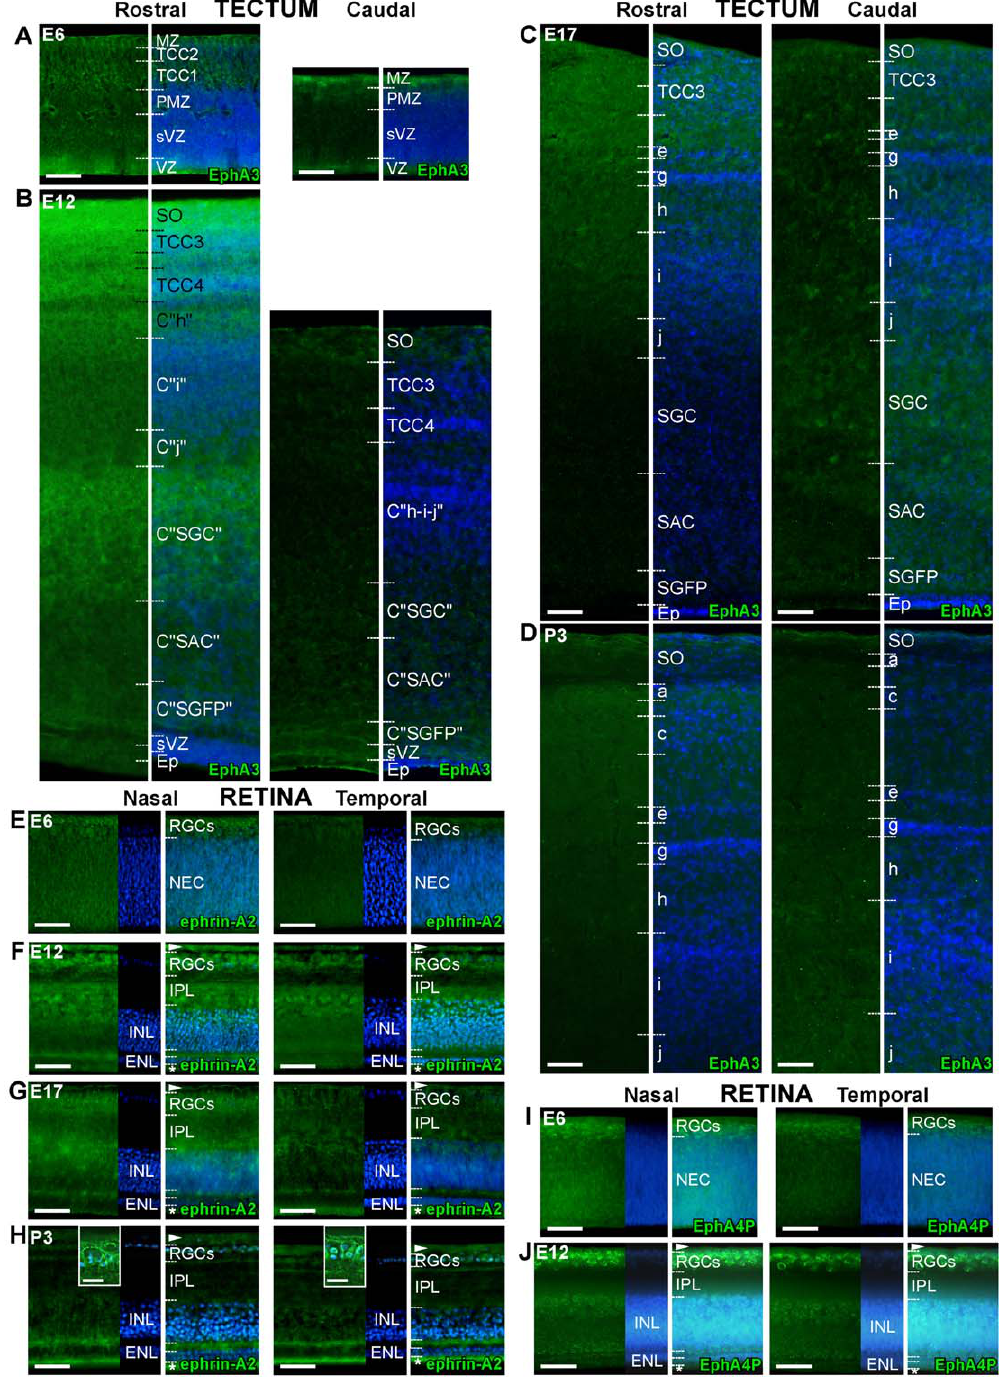
Figure 1. Developmental patterns of expression of tectal EphA3 and retinal ephrin-As and Tyr-602 phosphorylated-EphA4. (A–D) Immunofluorescence of EphA3 was performed in sections which extend along the rostro-caudal axis of tecta obtained from chicken embryos and early postnatal chicks. Photographs of rostral (left), and caudal (right) tectum obtained from the same section are successively shown at 6 (A), 12 (B), 17 days of development (C) (E6, E12, E17) and 3 postnatal days (P3) (D). Immunofluorescence (left) and merge image of immunofluorescence and nuclear labeling with Hoechst (right) of each area are shown. The lamination process is more advanced in rostral (left) than in caudal (right) tectum, so different developmental stages can be appreciated in different areas analyzed in the same age [3]. As lamination progresses, EphA3 is expressed along all the radial tectum in both areas, but the expression of superficial layers is higher in rostral than in caudal tectum. This pattern of expression is appreciated at E6 (A) and presents the highest level around E12 (B), decreasing postnatally (D). Ventricular zone (VZ), subventricular zone (SVZ), premigratory zone (PMZ), the transitory cell compartment 1 (TCC1), TCC2, TCC3, TCC4, C ‘‘stratum griseum periventriculare’’ (C ‘‘SGP’’), C ‘‘stratum album centrale’’ (C ‘‘SAC’’), C ‘‘stratum griseum centrale’’ (C ‘‘SGC’’), C ‘‘j’’, C ‘‘i’’; C ‘‘h’’; layers a, b, c, d, e, f, g, h, i, and j of the stratum griseum et fibrosum superficiale (SGFS); stratum opticum (SO) (for nomenclature see Material and Methods, [3,5]). Scale bars =50 m m. (E-H).